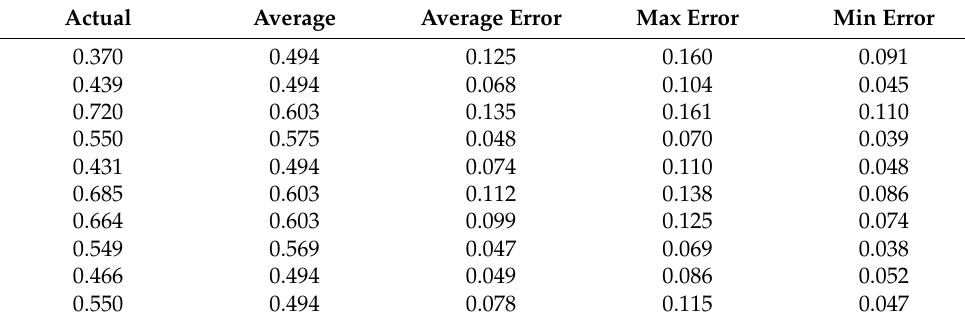
Table A218. Set 3, trials 41–50 data (actual PR value).